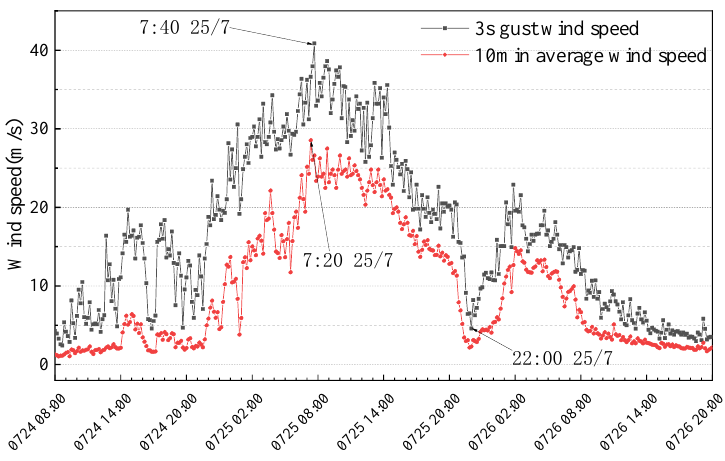
Figure 13. Typhoon wind speed measured at the site during the transit of typhoon In-Fa.